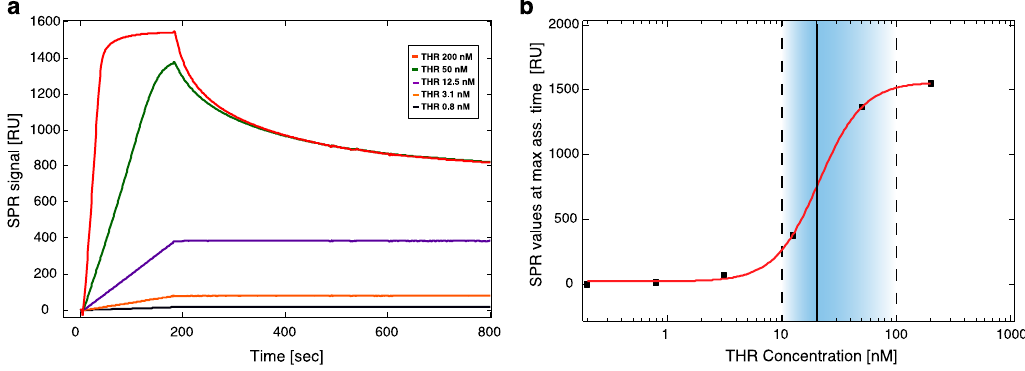
Figure 3. SPR characterization: ( a ) sensograms of different THR concentrations (0.8–200 nM); and ( b ) binding affinity analysis; SPR responses at the end of the association phase are plotted against THR concentration and fitted (red line) to a single site interaction model ([RU] = RU max − (1/(1 + K D /[A]))) the black vertical line indicates the value of K D found from the RU model; the light-blue area is the range of possible K D values (see text).